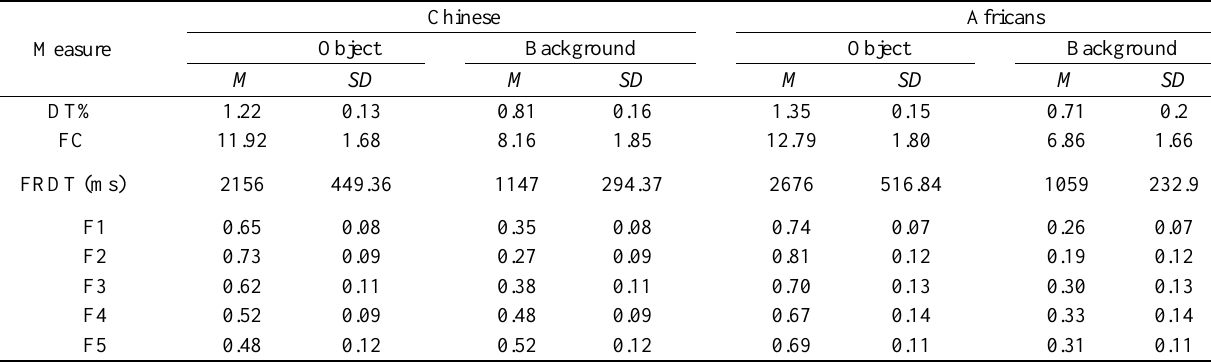
Table 1. Eye movement measures for objects and backgrounds in study phase Chinese Africans Object Background Object Measure